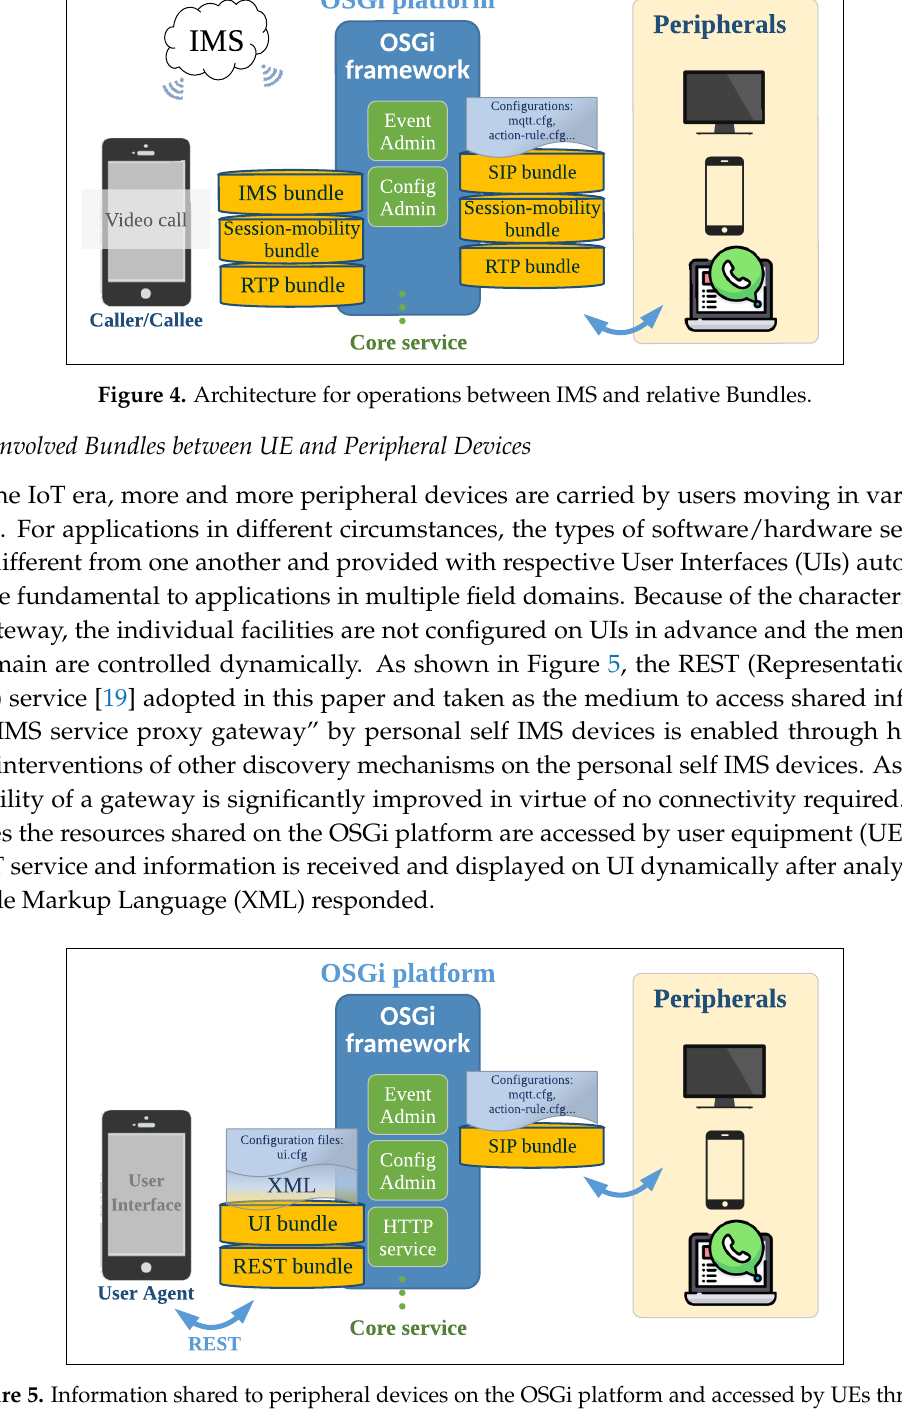
Figure 5. Information shared to peripheral devices on the OSGi platform and accessed by UEs through the REST